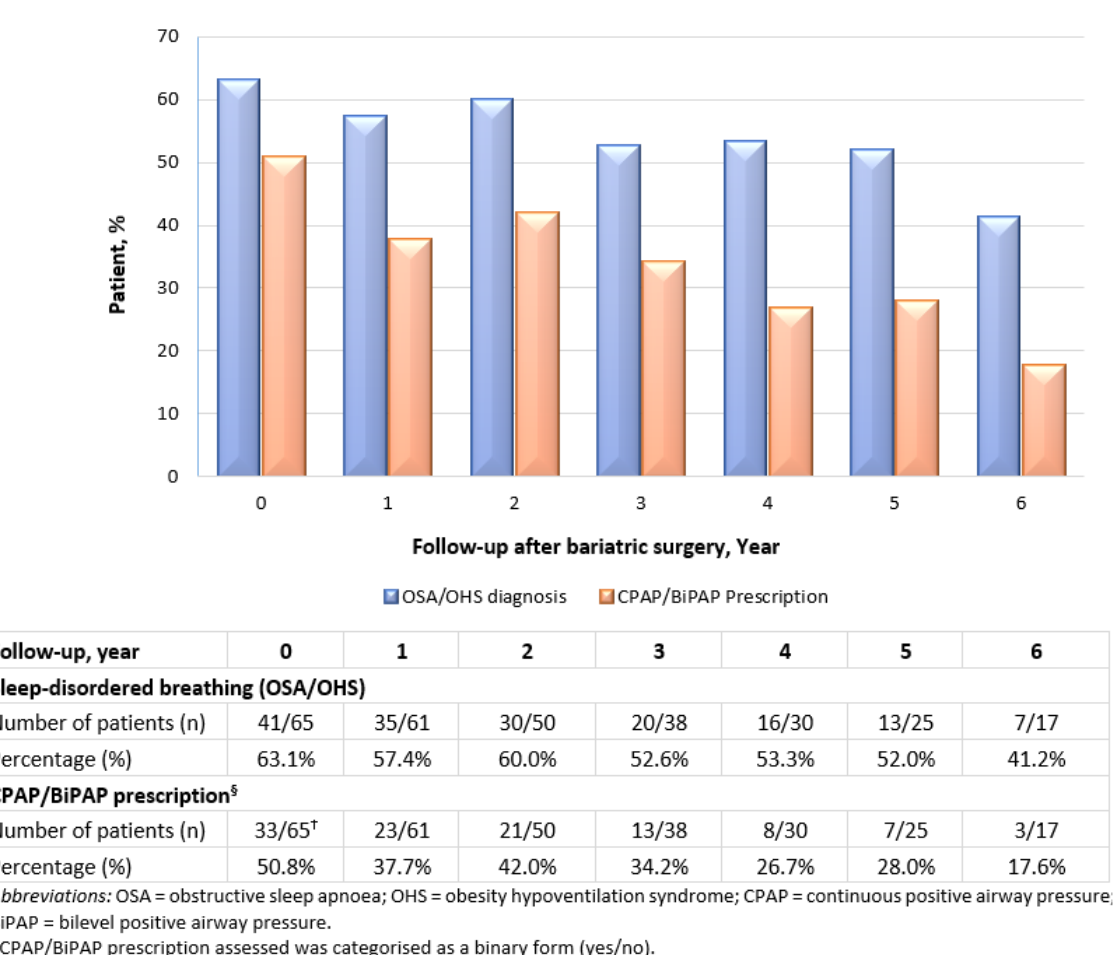
Figure 4. Prevalence of sleep-disordered breathing and CPAP/BiPAP prescription among the study population undergoing bariatric surgery.